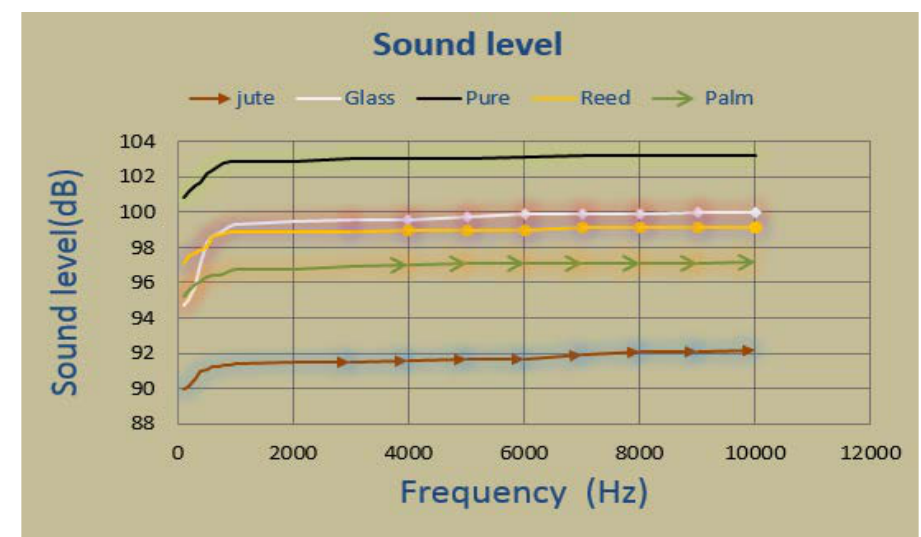
Fig. 9: Sound level-frequency relation for natural fibers composites with Glass fibers